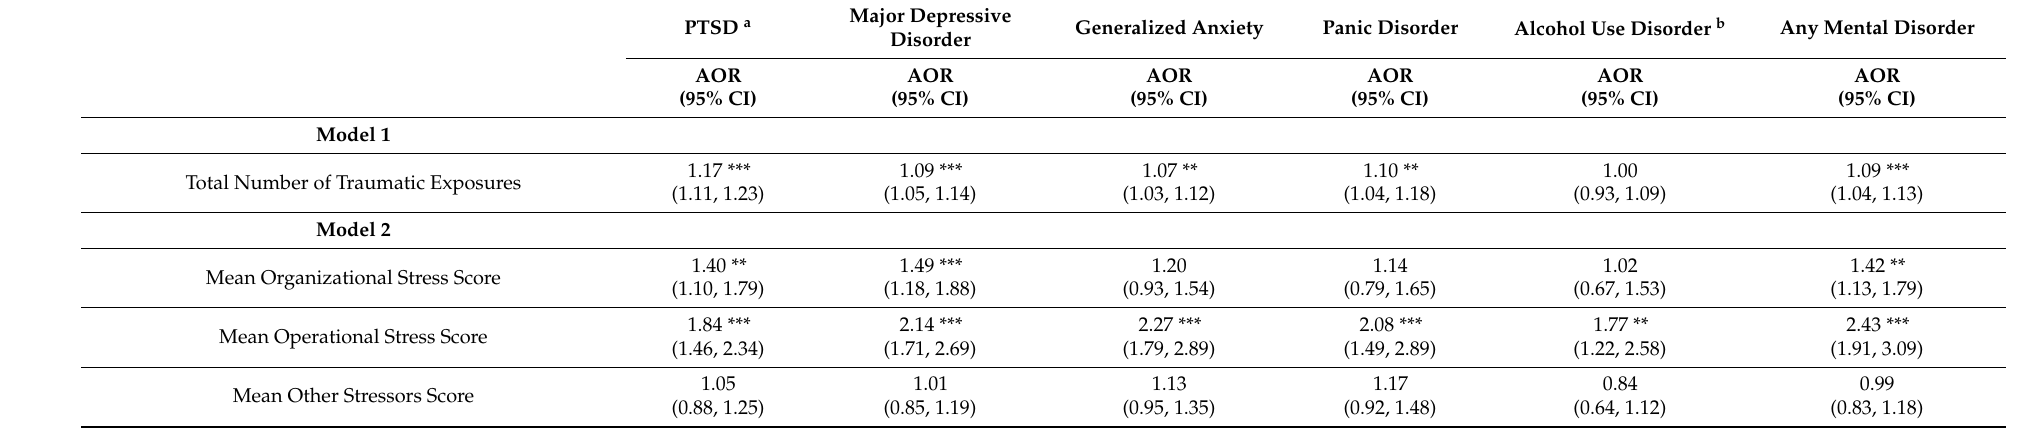
Table 4. Relationship between traumatic exposures, occupational stressors, and any positive mental disorder screen among correction workers in Ontario,